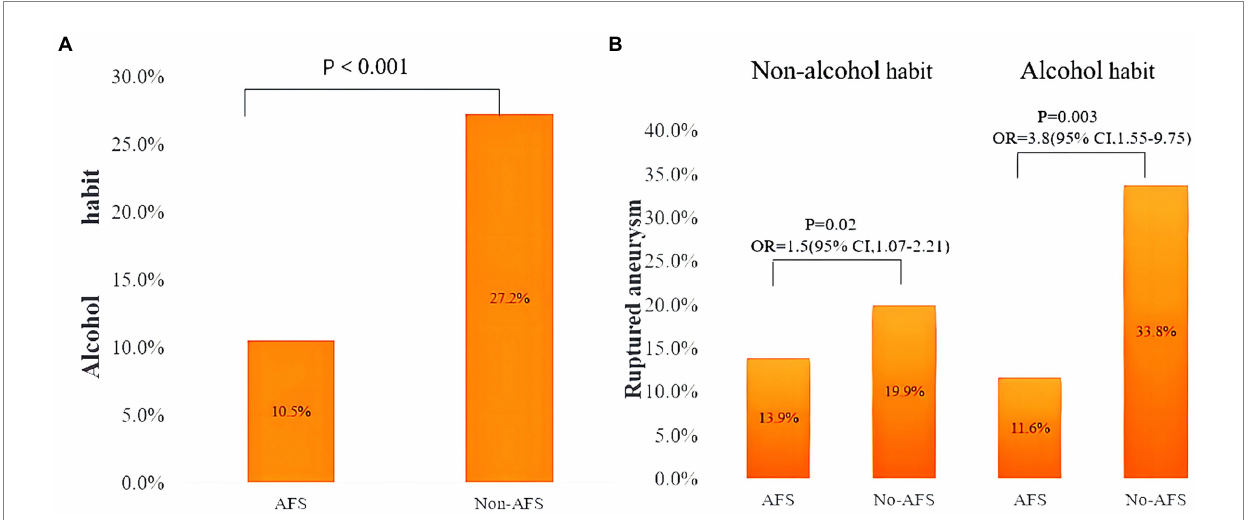
FIGURE 2 (A) Prevalence of habitual alcohol drinking in patients with and without alcohol flushing syndrome. (B) Prevalence of ruptured aneurysm with patients stratified according to both habitual alcohol drinking and presence of alcohol flushing syndrome. OR, odds ratio; CI, confidence interval; AFS, alcohol flushing